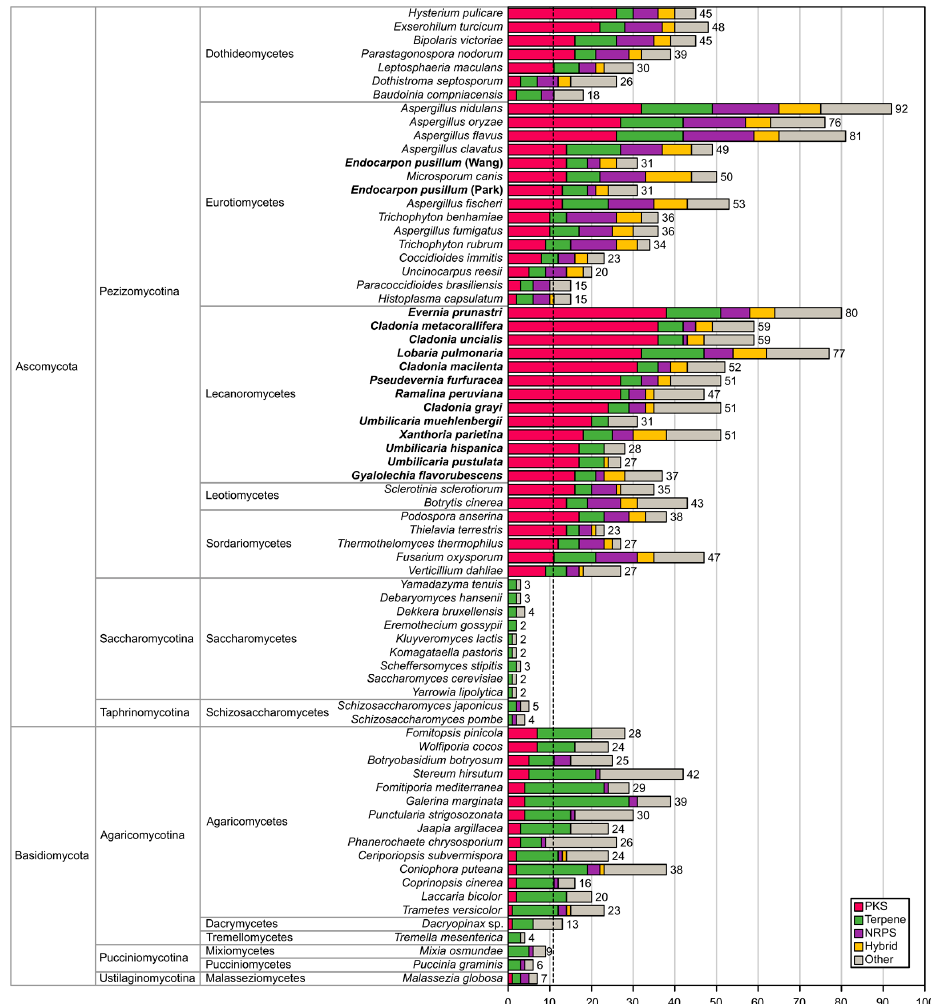
Figure 2. Overview of predicted secondary metabolic gene clusters across the genomes of representative fungal species adopted from [32]. Bold font indicates genomes of lichen-forming fungi included from this study. The dashed line shows the average number of PKS gene clusters found in a genome. “Hybrid” refers to clusters with multiple core genes belonging to different secondary metabolite families. PKS = polyketide synthase; NRPS = non-ribosomal peptide synthetase.